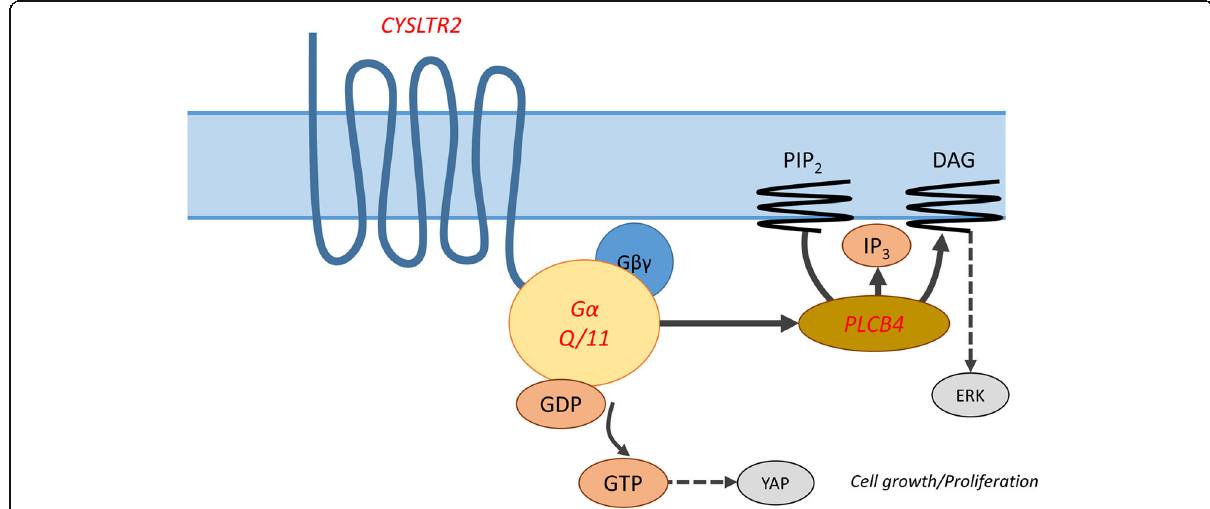
Fig. 3 G α q signalling in uveal melanoma is achieved by mutations in CYSLTR2 . GNAQ/11 and PLCB4 . (Modified from the figure in